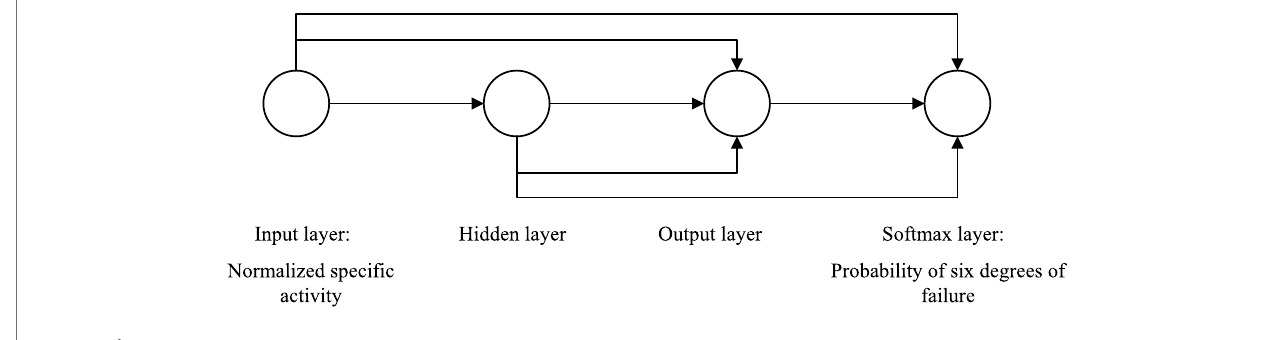
FIGURE 2 | Structure of the CFNN used for fuel failure detection.